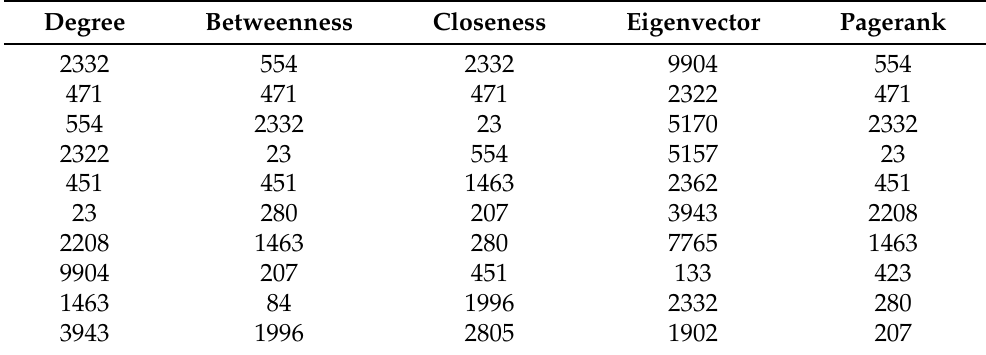
Table 4. Ranking of the 10 most important nodes for the facebook network identified by the centrality function of Matlab.